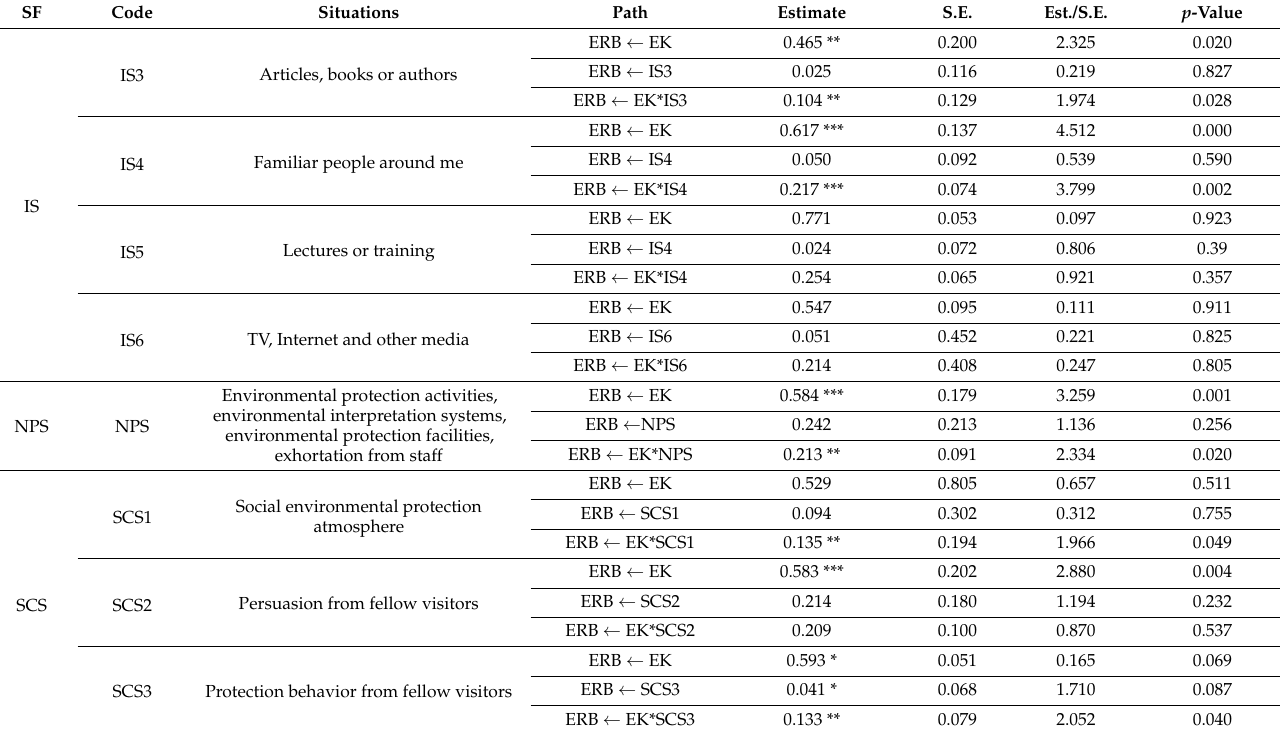
Table 7. Comparison of moderating effects in different